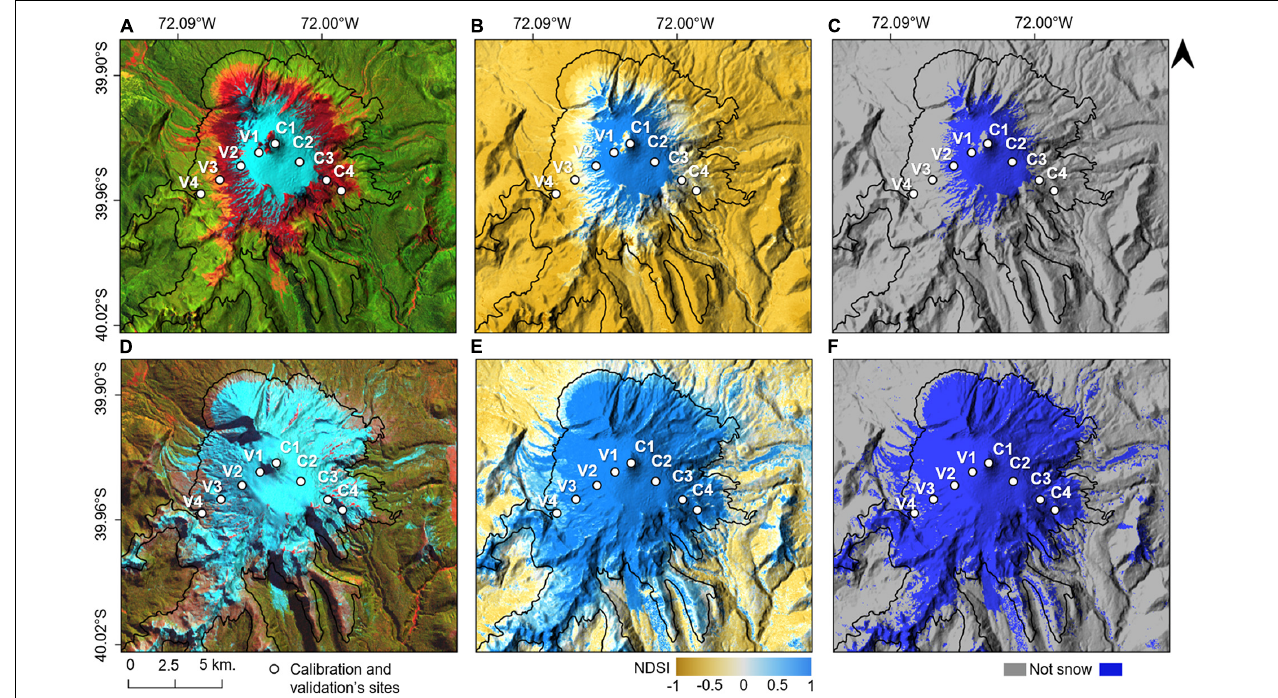
FIGURE 2 | Snow detection approach using Landsat images. (A,D) correspond to a false color composition (SWIR-NIR-Red) of Landsat images, (B,E) are the Normalized Difference Snow Index (NDSI) images calculated from Landsat, and (C,F) are binary “snow” and “not-snow” images calculated using a fixed threshold. Upper panels (A–C) correspond to a Landsat image acquired in summer (23-01-2019) and (D–F) in winter